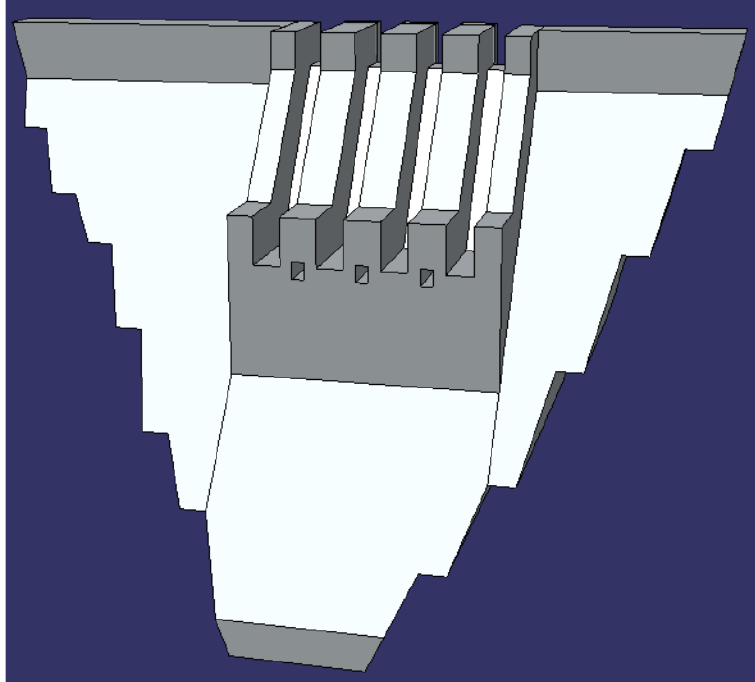
Figure 7. Three-dimensional model of the RCC gravity